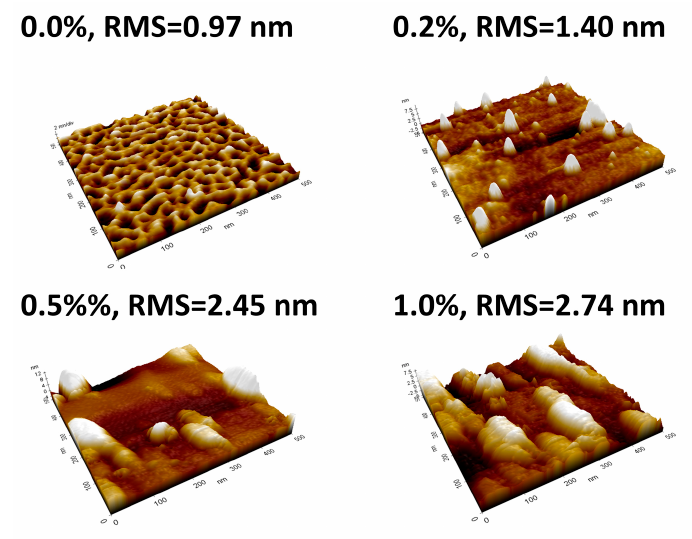
Figure 2. SPM Images and RMS values, with different Ywt%.